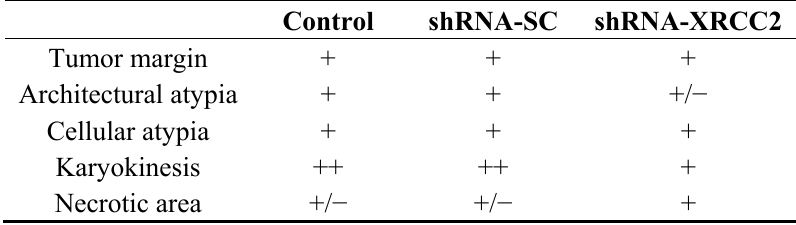
Table 1. Pathological analysis of harvested tumors in nude